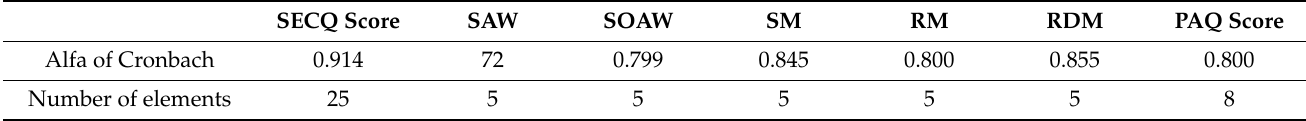
Table 1. Reliability by factors and